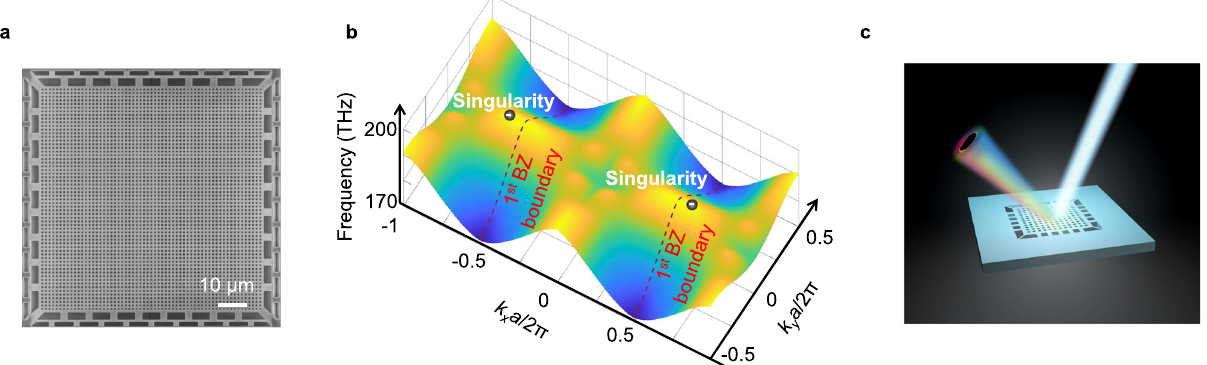
Fig. 1 | Scanning electron microscope (SEM) image and band diagram of a topologicalpolarizationsingularlaser.a SEMimageofatopologicalpolarization singular laser, where a semiconductor membrane serves as photonic crystal and gain material simultaneously. The lattice constant ( a ) is ~1240nm, and the opera- tion wavelength ( λ ) is ~1567nm in free space. The length of the reciprocal lattice vector ( G 0 = 2 π a ) is smaller than the diameter of light cone ( 4 π λ ), which allows